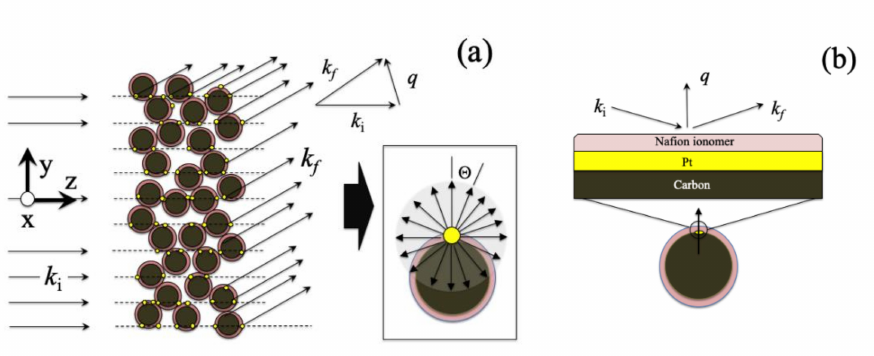
Figure 15. Schematic diagrams of ( a ) the normal powder catalyst and ( b ) the model system (for reflection geometry or in-situ grazing-incidence scattering (GISANS)) consisting of a spin-coated layer on a Si